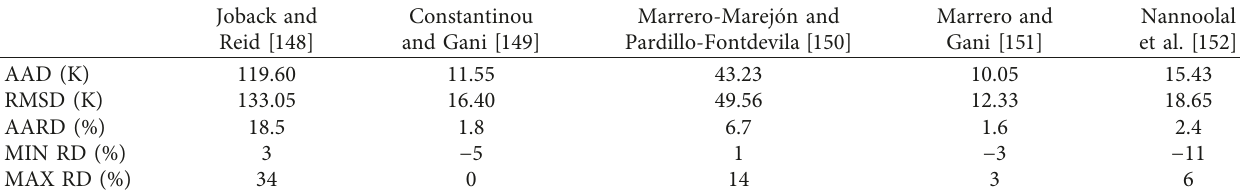
Table 5: Deviations of the different methods for the normal boiling point estimation.